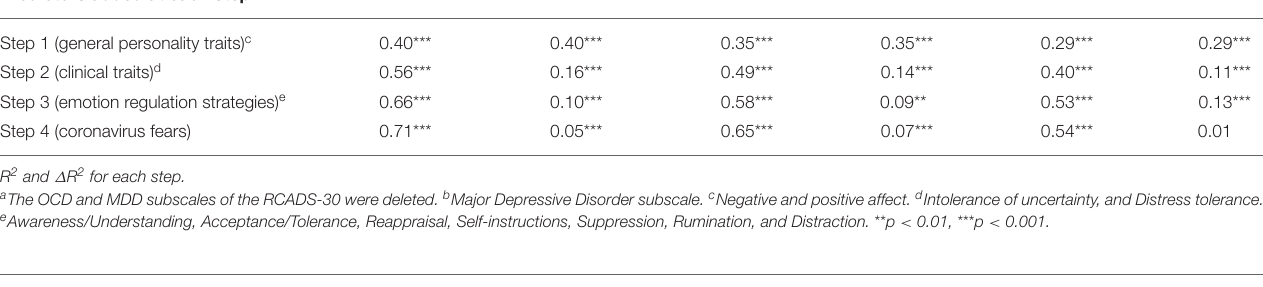
TABLE 4 | Hierarchical multiple regression analyses examining the role of transdiagnostic measures and coronavirus fears in the prediction of anxiety and depressive disorder symptoms.